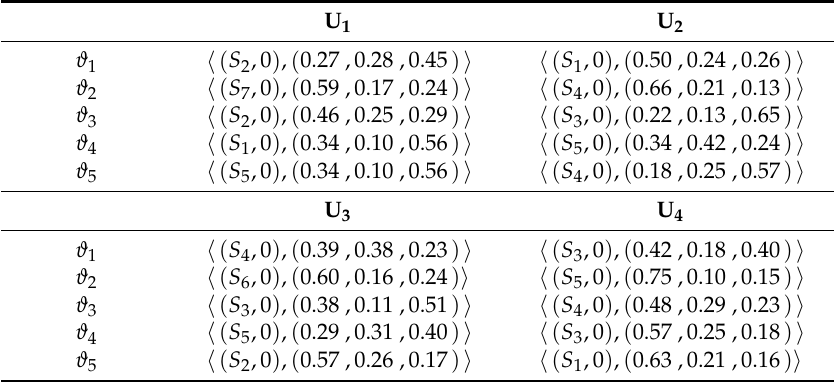
Table 2. Picture 2-tuple linguistic evaluation information by q 2 .